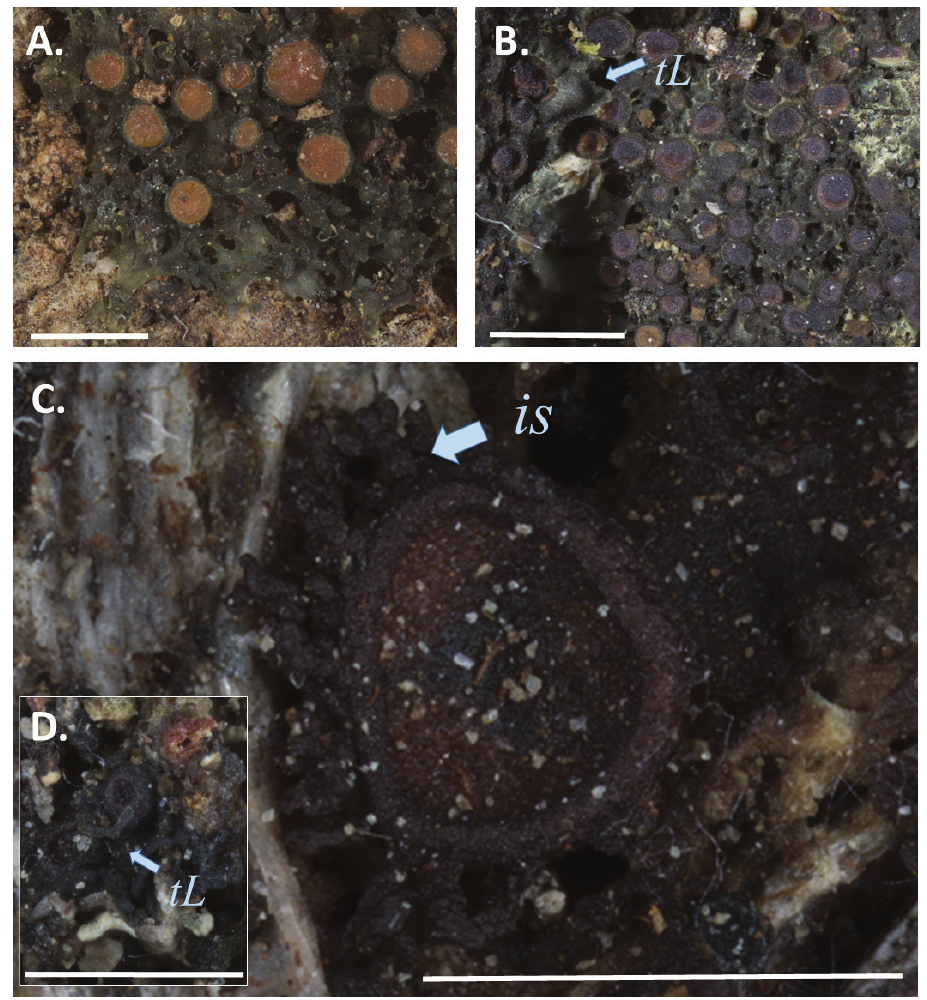
Figure 4. Thallus habitus: A Rostania coccophylla (isotype of Collema coccophyllum Nyl., India, 1858, Per- rotet s.n., H-NYL 42355, H–9201376) B Rostania paramensis (Palice 2796, PRA-00013999; holotype of Collema paramense PM Jørg. & Palice) C Scytinium sp. Palice 2274a D Rostania paramensis Palice 2274b. tL = thalline lobes, is = isidia. Scale bar: 1